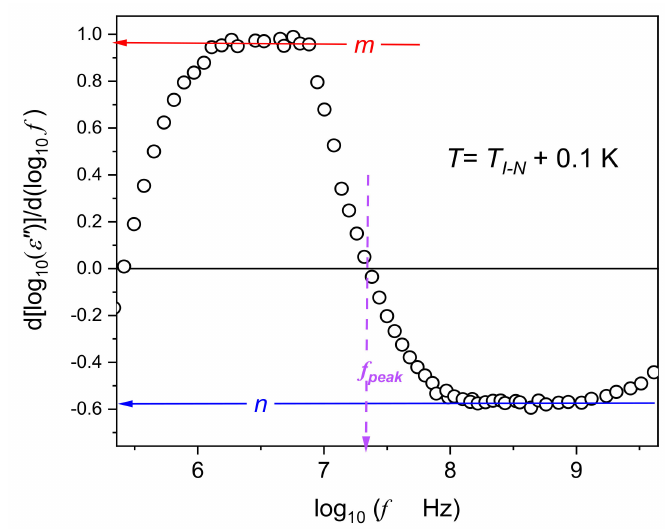
Figure A2. The derivative-based and distortions-sensitive analysis of the primary relaxation loss curve (Equations (A4)–(A6)) in the isotropic phase of 5CB, the immediate vicinity of the clearing temperature. The plot explores experimental data from Figure A1. Notable is the clear manifestation of the Jonsher’s scaling (Equations (A1)–(A4)), although in a limited range of frequencies. There are no hallmarks of an additional relaxation process.